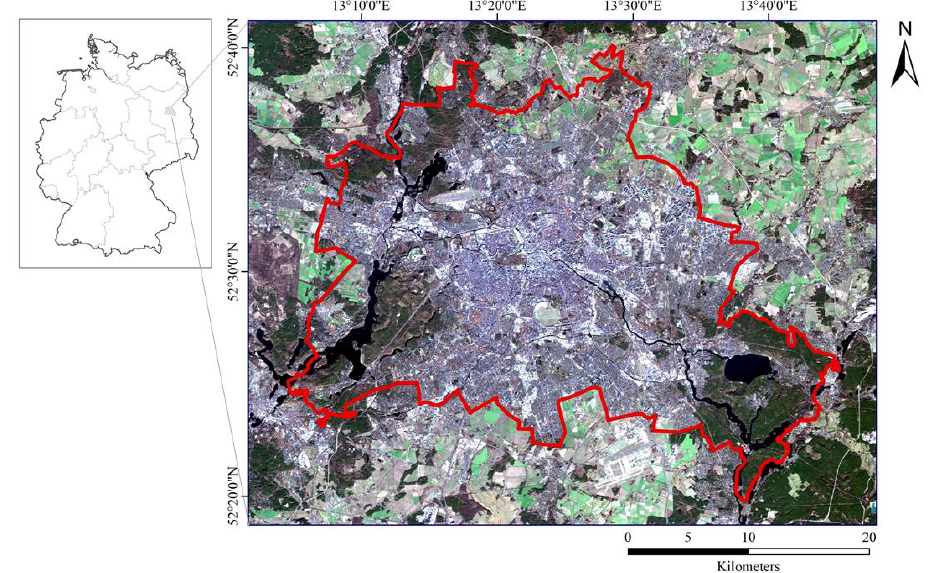
Figure 1. The study area of Berlin (red boundary) represented in a Landsat 8 image.